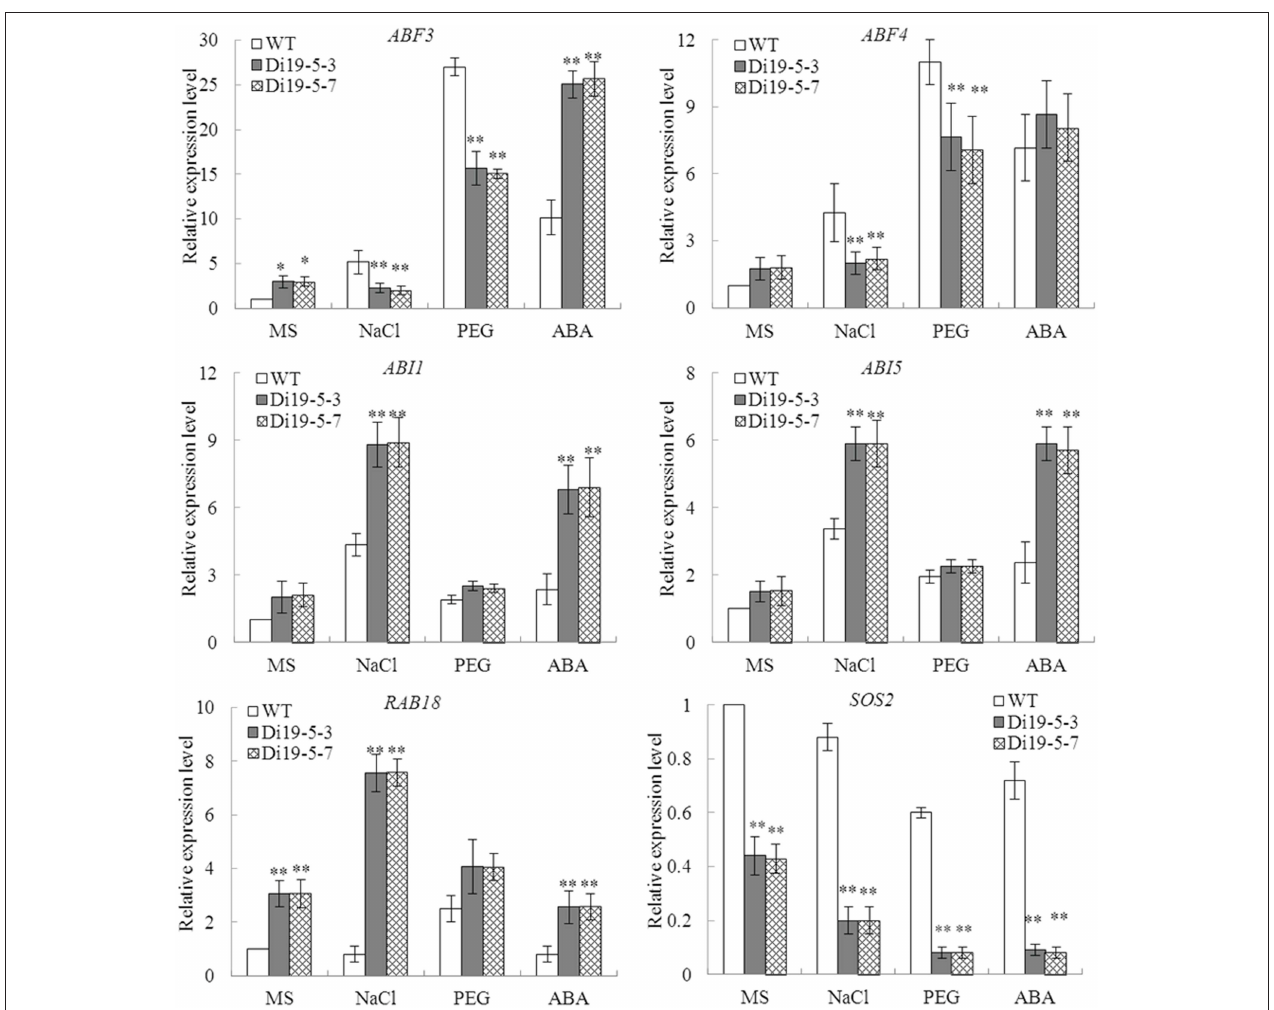
FIGURE 11 | Expression of stress-responsive genes in GmDi19-5 transgenic Arabidopsis . * and ** indicated significant differences in comparison with the WT lines at 0.01 < P < 0 . 05 and P < 0 . 01 , respectively ( t